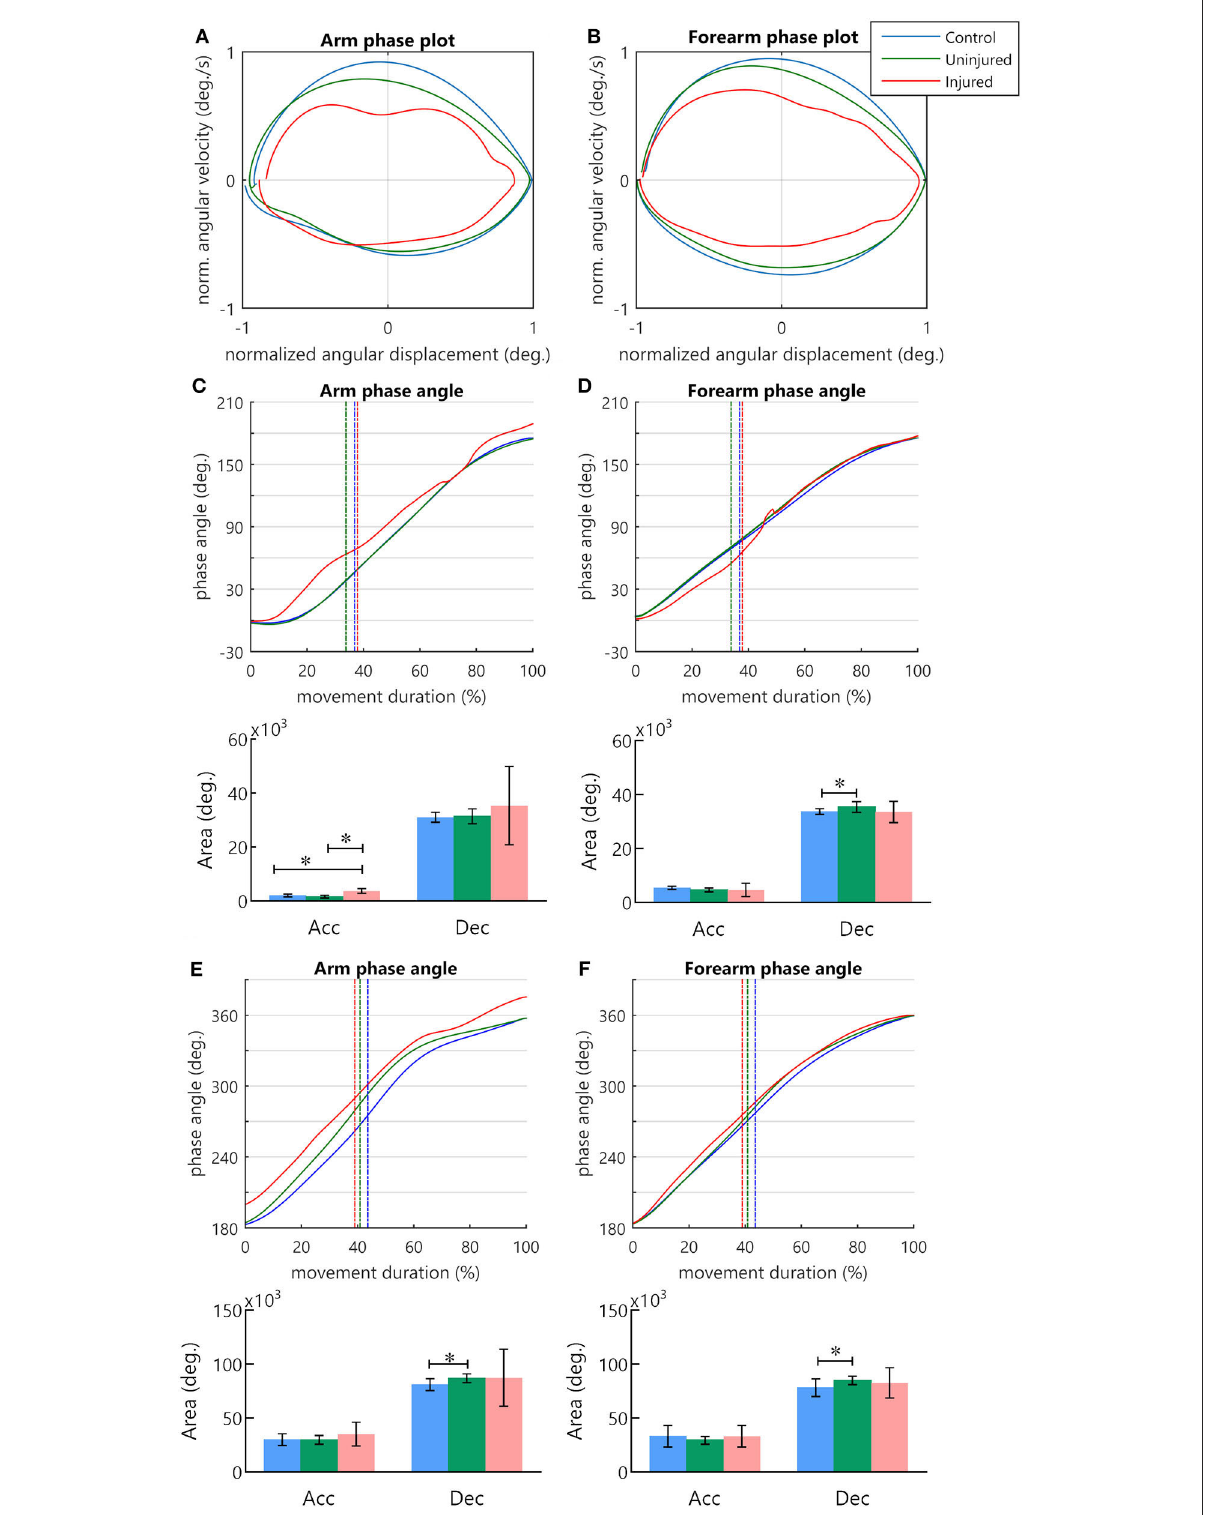
FIGURE3 The phase angle of arm and forearm kinematics. (A,B) Arm and forearm phase plots. (C–F) Arm and forearm dynamics during the cycle of movement. The mean phase angle (filled line) is plotted for each group and the vertical dashed line indicates the moment in which the hand achieves the peak velocity. The result of the area calculation is expressed in a bar graph under each phase angle plot. (C,D) Arm and forearm phase angle during transport to mouth. (E,F) Arm and forearm phase angle in the return to the starting position. *statistical difference between groups ( p <